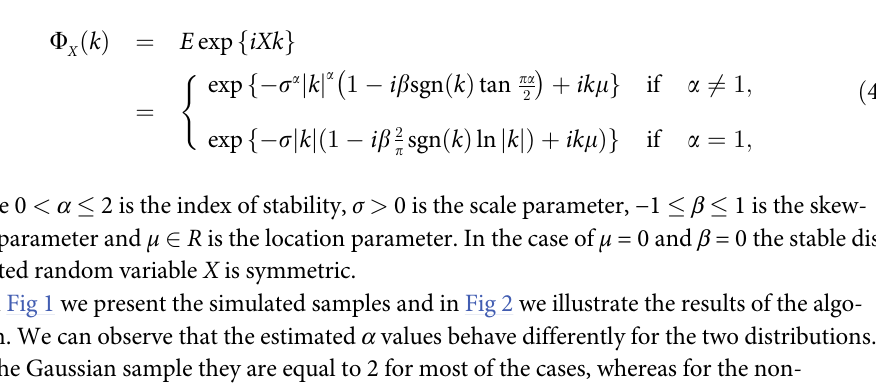
Fig 1. Simulated samples from the Gaussian distribution with μ = 0 and s ¼ and σ = 1 (top right panel), and their empirical tails (1-CDFs) in log-log scale (bottom left panel) and PDFs (bottom right